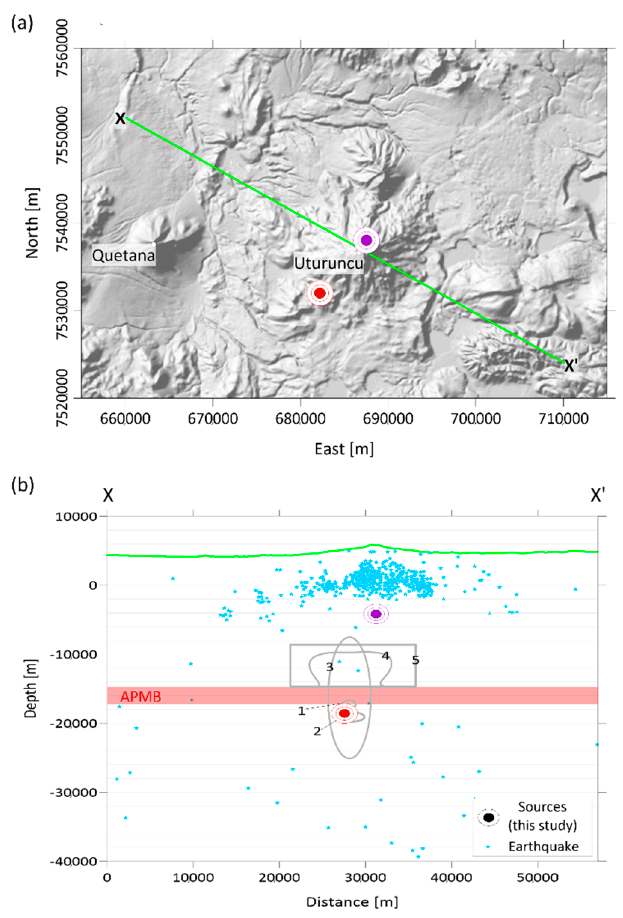
Figure 6. Location and depth of deformation sources. ( a ) SRTM DEM of the study area with the green continuous line representing the XX’ trace and the red and the violet solid circles indicating the position of the deep and the shallow deformation sources, respectively; ( b ) XX’ section redrawn from [21,23,24], in which the location and depth of retrieved deformation sources are reported; the solid blue stars represent earthquake locations; the red solid rectangle indicates the depths to the APMB [15], while the green continuous line represents the topography; the grey continuous lines, numbered from 1 to 5, indicate the solutions proposed by 1-Pritchard and Simons [26], 2-Pritchard and Simons [26], 3-Hickey et al. [29], 4-Fialko and Pearse [27], 5-Walter and Motagh [30], respectively. Table 2. Summary of deformation sources. Volcanic source modeling for APMB and Uturuncu volcano retrieved from satellite geodetic measurements. Where not specified, depths are referred to sea level.